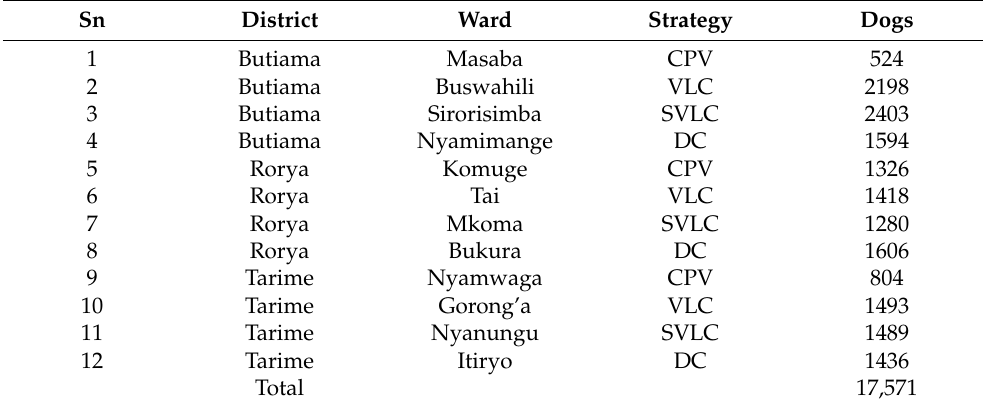
Table 1. Numbers of dogs vaccinated across the different strategies.